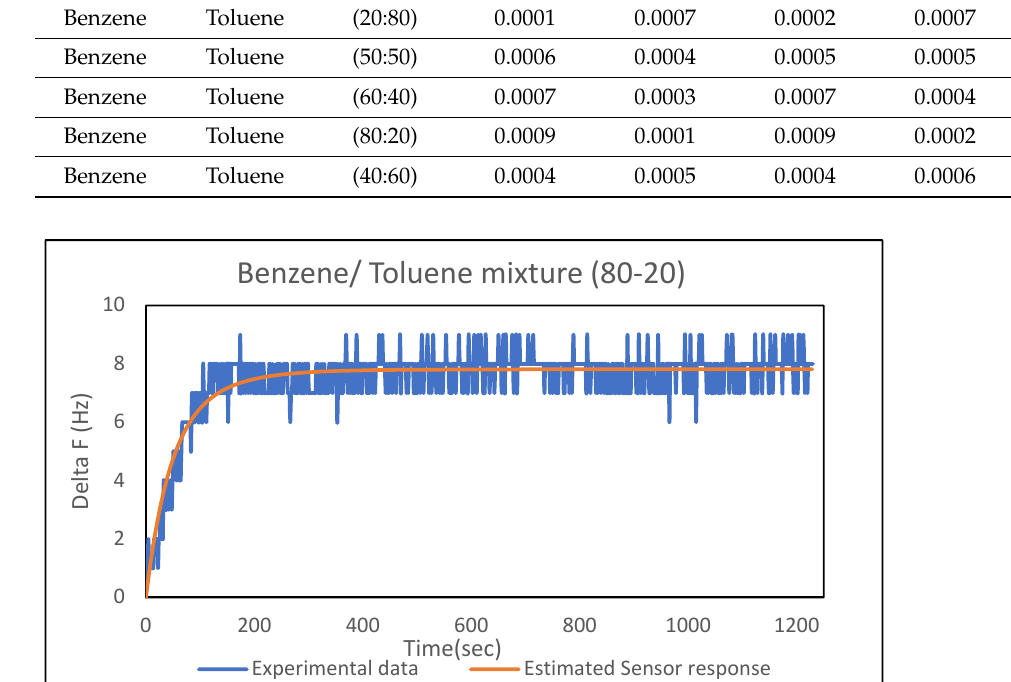
Table 6. Comparison of regressed mole fractions y 1 ,amb and y 2 ,amb to actual mole fractions y 1 ,act and y 2 ,act of binary mixtures of benzene and toluene at various concentrations.